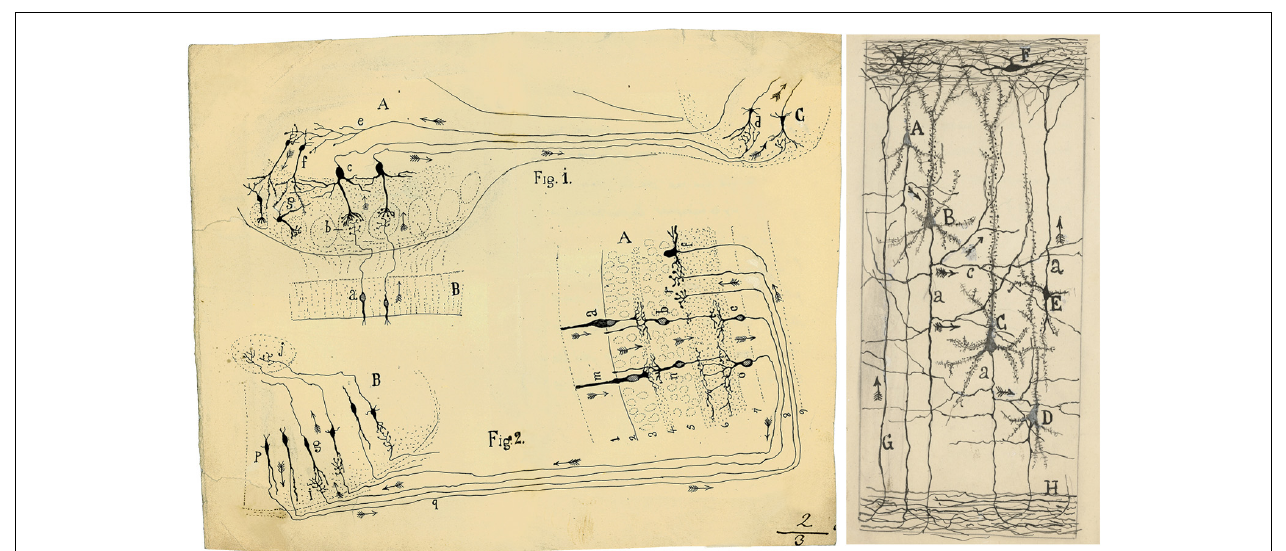
cell of the retina, respectively, the order through which visual excitation travels. m, n, o, parallel current emanating from the rod also involves bipolar and ganglion cells. g , cells of the optic lobe that receive the visual excitation and transfer it to j , the central ganglion. p, q, r , centrifugal currents that start in certain fusiform cells of the optic lobe and terminate in r , in the retina at the level of the spongioblasts; f , a spongioblast. (Right) Schematic drawing by Cajal to show synaptic connections and the possible flow of information through neural circuits in the cerebral cortex. Taken from Neuronismo o reticularismo? (Cajal, 1933). A , small pyramid; B and C , medium and giant pyramids respectively; a, axon; [ c ], nervous collaterals that appear to cross and touch the dendrites and the trunks [apical dendrites] of the pyramids; H , white matter; [ E , Martinotti cell with ascending axon]; F , special cells of the first layer of cerebral cortex; G , fibre coming from the white matter. The arrows mark the supposed direction of the nervous